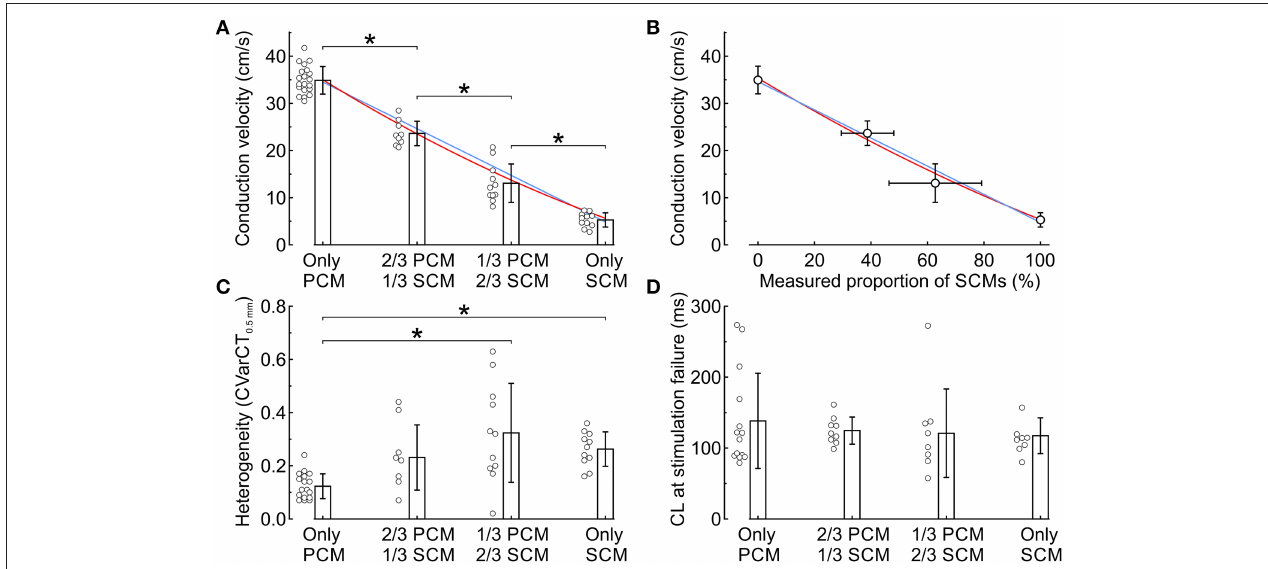
FIGURE 3 | Electrophysiological characteristics in co-cultured strands of PCMs and SCMs as a function of the relative proportion of the two cell types. (A) Conduction velocity vs. seeded proportion of SCMs. The blue line and the red curve represent linear and quadratic fits to the data, respectively. (B) Conduction velocity vs. measured proportion of SCMs. The blue line and the red curve represent linear and quadratic fits to the data, respectively. (C) Heterogeneity index CVarCT